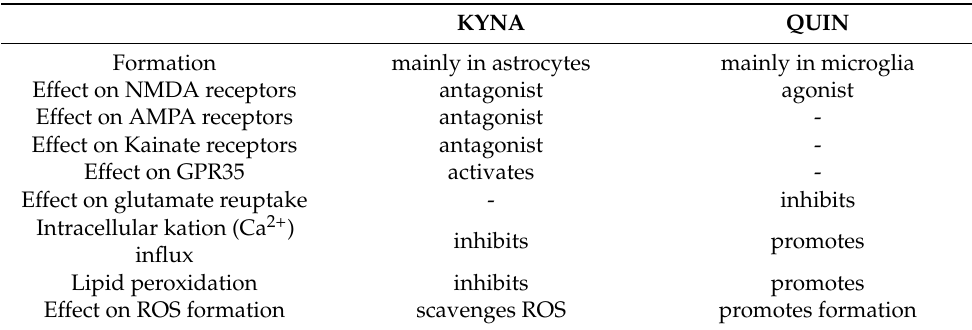
Table 1. The antagonistic effect of kynurenic acid and quinolinic acid. KYNA QUIN Formation mainly in astrocytes mainly in microglia Effect on NMDA receptors antagonist agonist Effect on AMPA receptors antagonist - Effect on Kainate receptors antagonist - Effect on GPR35 activates - Effect on glutamate reuptake - inhibits Intracellular kation (Ca 2+ ) inhibits promotes influx Lipid peroxidation inhibits promotes Effect on ROS formation scavenges ROS promotes formation KYNA, kynurenic acid; QUIN, quinolinic acid; NMDA, N -methyl- D -aspartate; AMPA, α -amino-3-hydroxy-5- methyl-4-isoxazolepropionic acid; GPR35, orphan G-protein coupled receptor; ROS, reactive oxygen